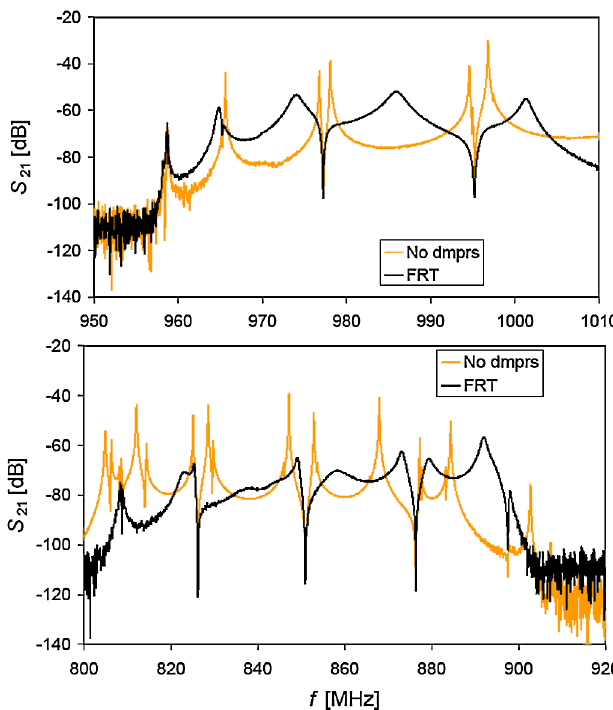
FIG. 26. Frequency spectrum of ferrite damper between Cu cavities.